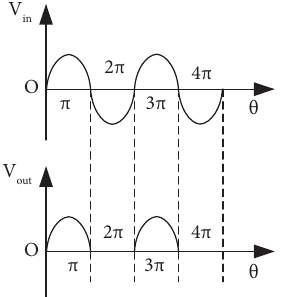
Figure 1: One-directional conductivity of diode.